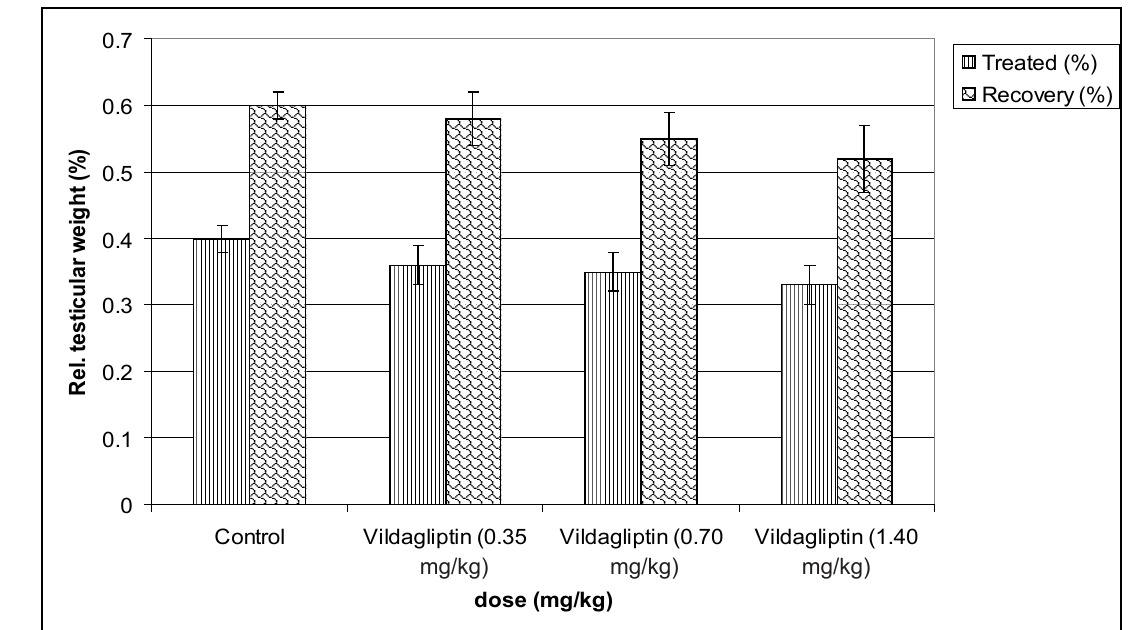
FIGURE 2 – Effects of vildagliptin on relative testicular weight of male Wistar rats.